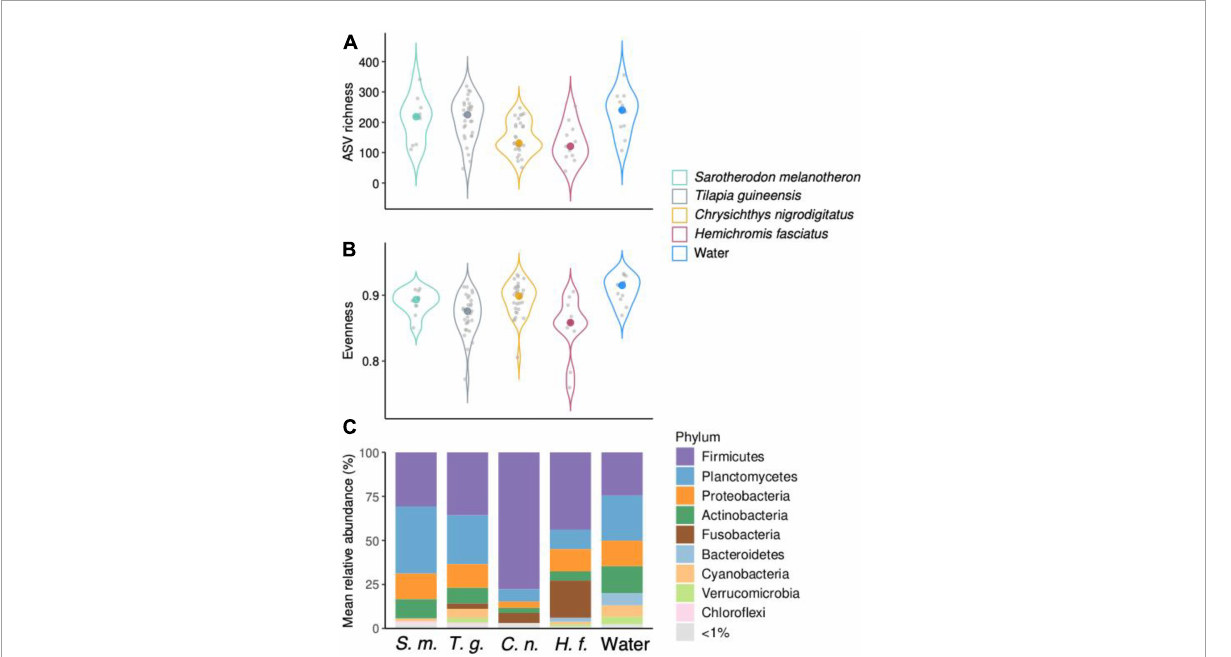
FIGURE2 (A,B) Amplicon Sequence Variants (ASV) richness and evenness indices of bacterial communities from water and fish gut samples over all sampled months. Colored dots represent median values. (C) Mean relative abundance of the bacterial taxa at the phylum level across water and